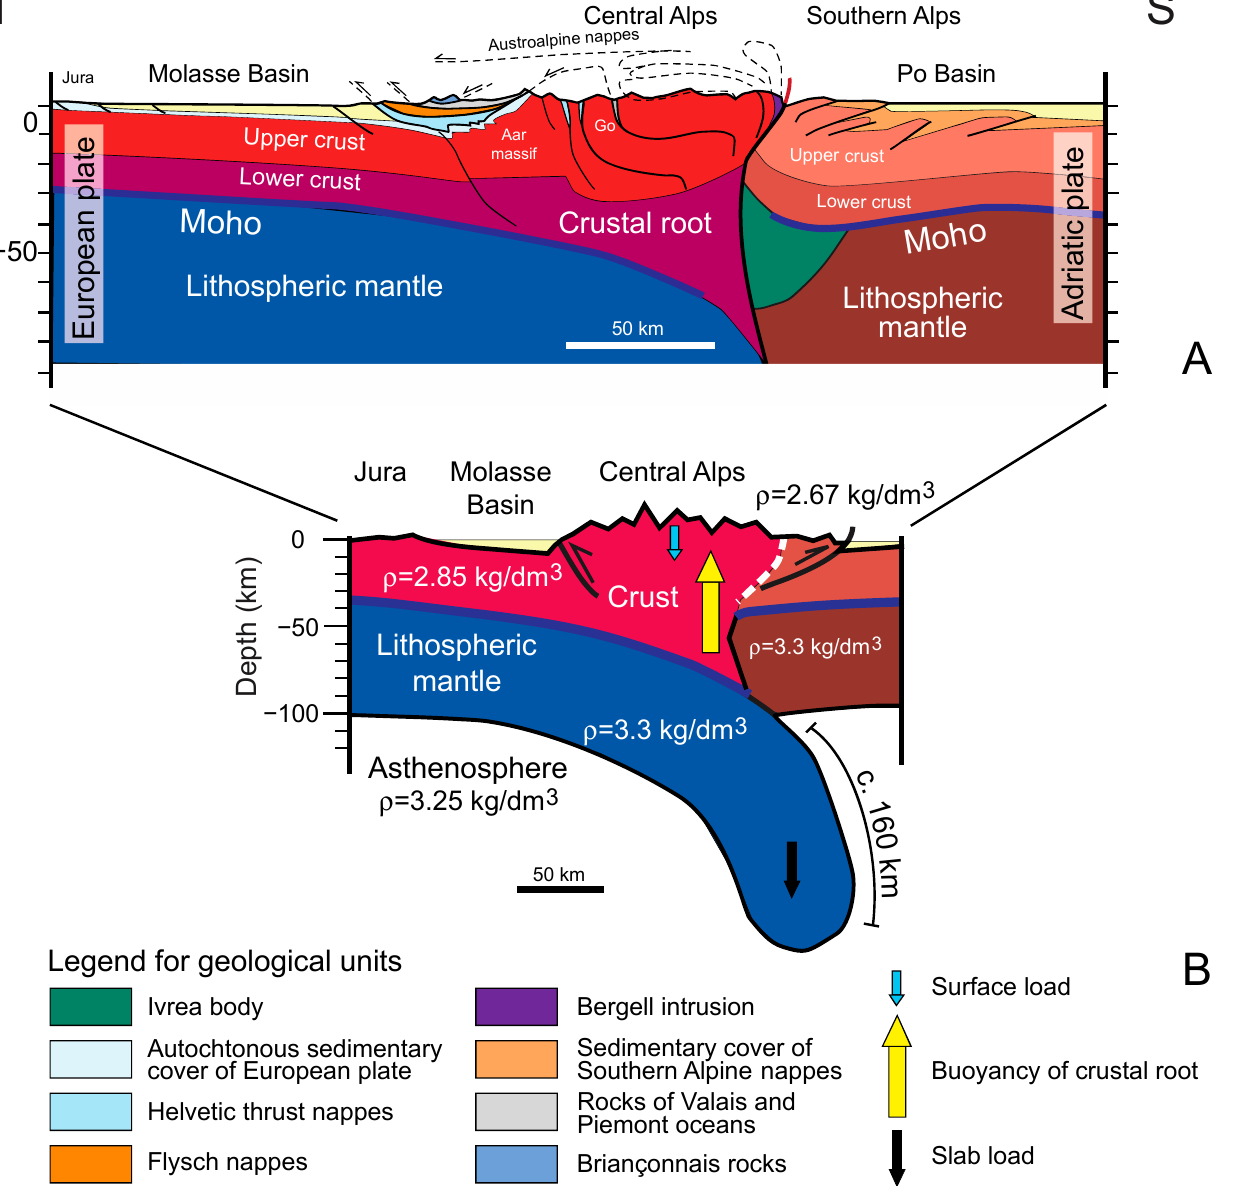
Figure 3. ( A ) Tectonic section across the Central Alps [33] (for location see Figure 2). On the northern side, the orogen comprises a nappe stack derived from the European plate and its stretched margin together with slivers of the Iberian plate that formed part of the European plate since 35 Ma. ( B ) Simplified geological-geophysical model of the Central Alps (along same section as Figure 3A), derived from seismo-tomographic images [29,33]. The lithospheric mantle has a greater density than the asthenosphere. Therefore, it exerts a downward-directed slab load force. The crustal root, occurring at deep levels, comprises lower crustal rocks, which were derived through accretion of material from the Iberian plate and the European margin. These rocks have a lower density than the asthenosphere and thus exert a buoyancy force. The elevation of the current topography of the Central Alps thus reflects the isostatic equilibrium between these forces.